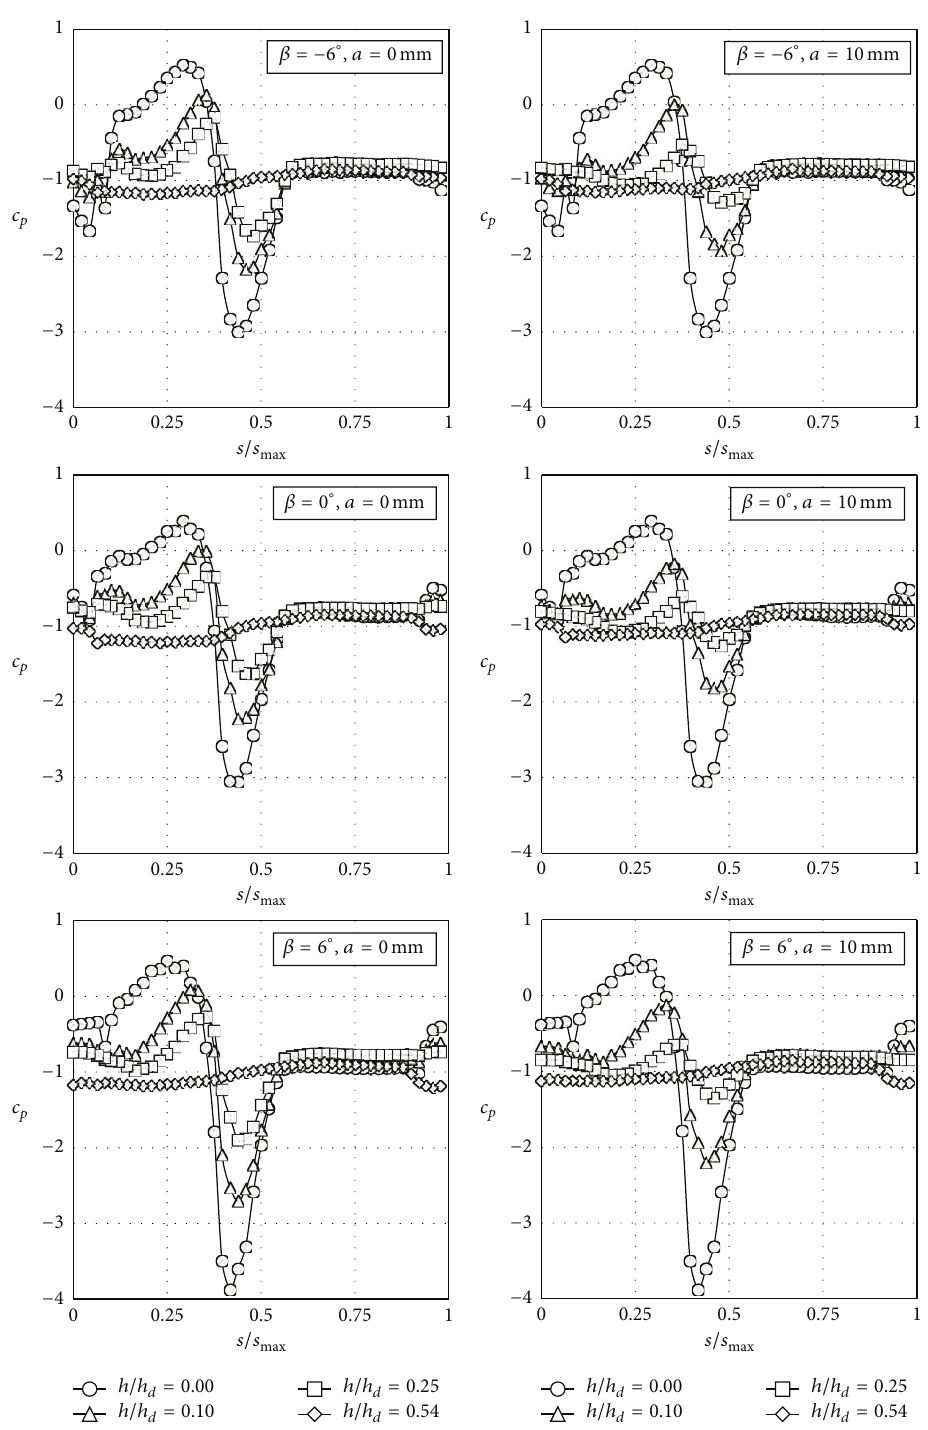
is closer to this corner. However, for ℎ/ℎ 𝑑 = 0.34